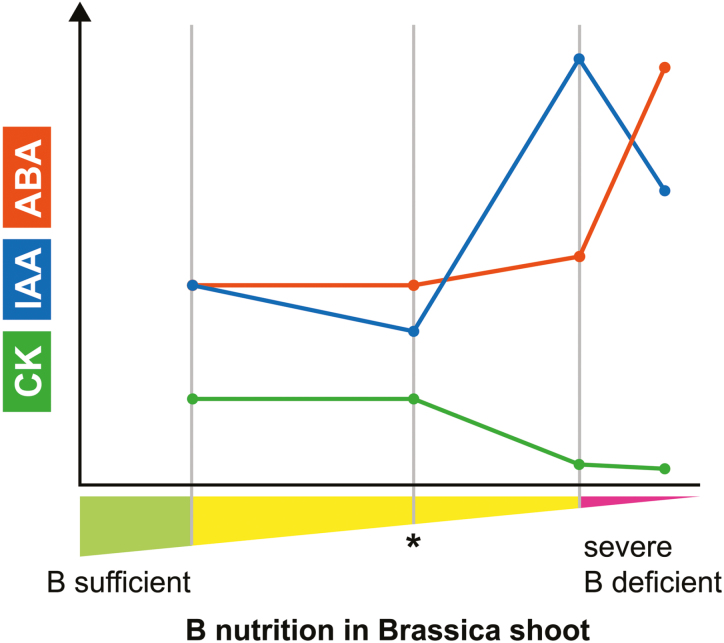
Trends of IAA, ABA, and CK levels with increasing B deficiency in Brassica napus plants. Modified from Eggert and von Wirén (2017) with permission.